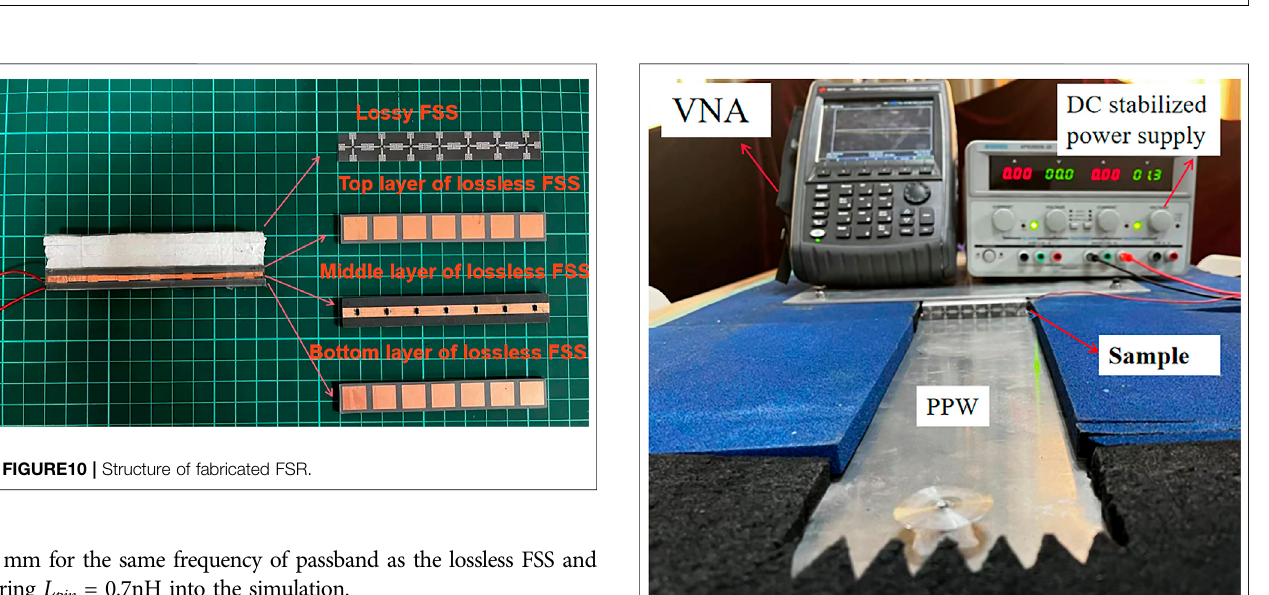
FIGURE 9 | (A) S-parameter of recon fi gurable FSR with PIN diodes ON. (B) S-parameter of recon fi gurable FSR with PIN diodes OFF.